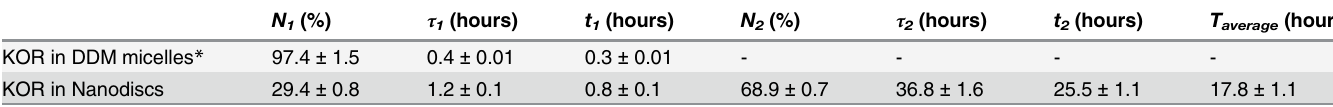
Table 1. Quantification of high-affinity ligand binding to KOR in detergent micelles or when reconstituted in Nanodiscs.